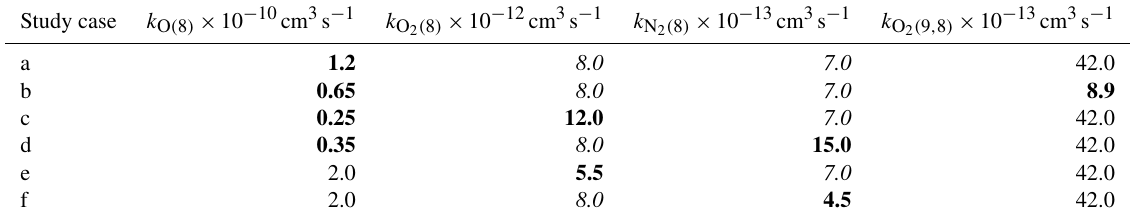
Table A1. The comparison of study cases with the applied rate coefficients being summarized. The adjusted parameters and their fitted values are marked in bold, while the coefficients taken from laboratory measurements are marked in